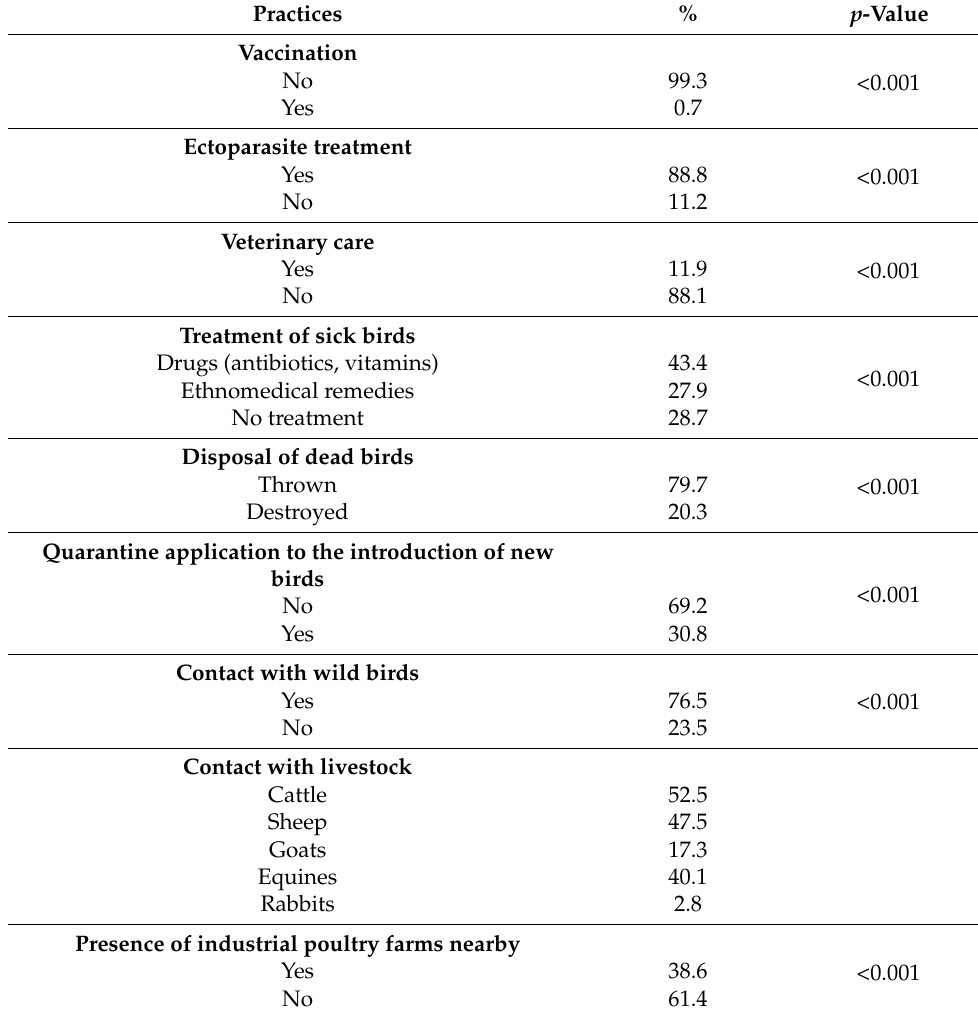
Table 3. Flock owners’ responses to poultry health management and biosecurity practices in